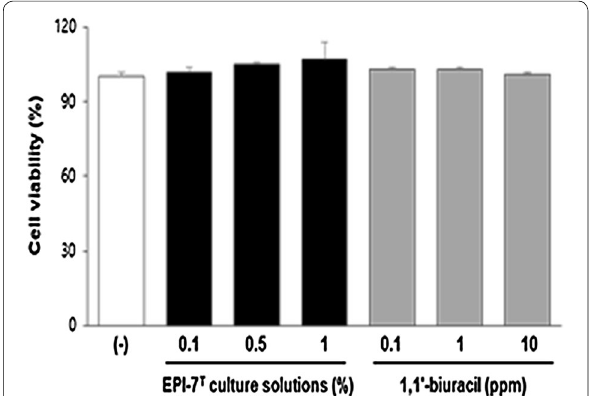
Fig. 3 Cell viability of EPI‑7 T culture solutions and 1,1 ′ ‑biuracil in Hs68 human fibroblasts